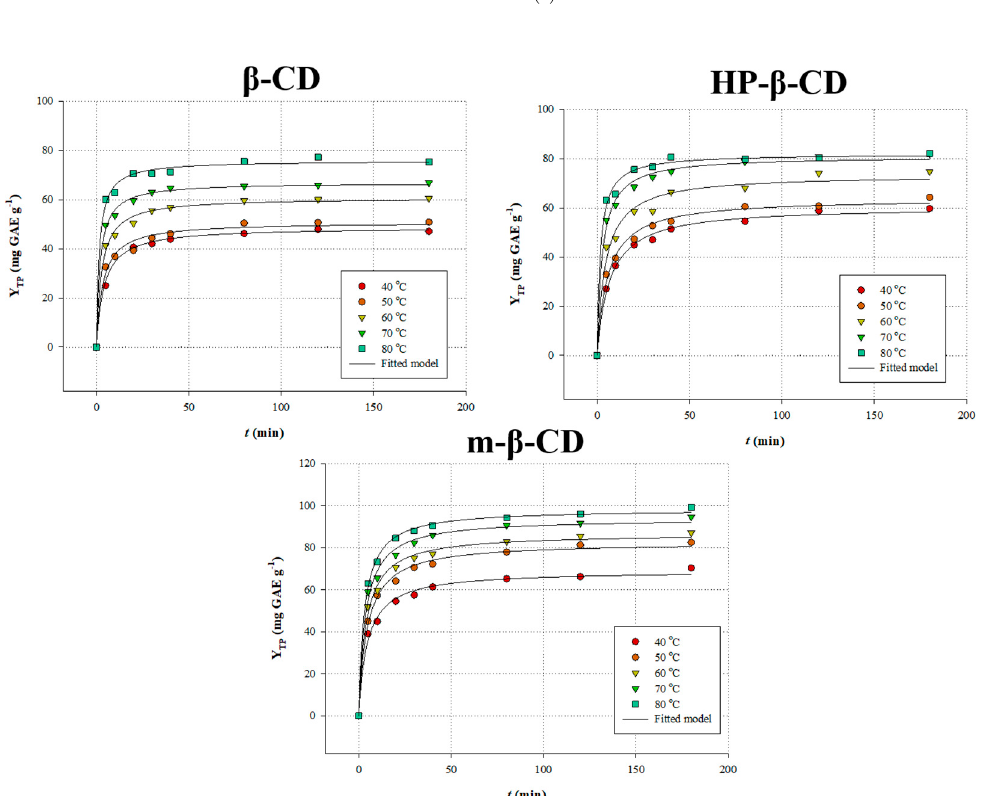
Figure 4. Kinetics of polyphenol extraction from S. fruticosa , with each of the CDs tested, within a range from 40 to 80 °C. Extractions were performed under optimized conditions. Assignments: m- β -CD, methyl β -cyclodextrin; HP- β -CD, hydroxypropyl β -cyclodextrin; β -CD, β -cyclodextrin.